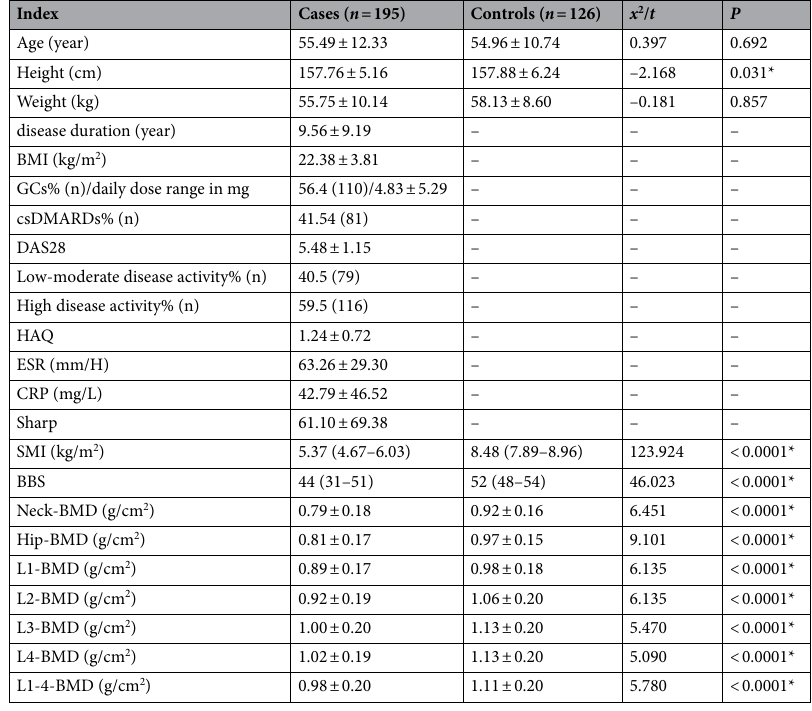
Table 1. Comparison of clinical features between female RA and controls. Mean and standard deviation for the continuous variables and number of participants (n) and percentages (%) for the categorical variables. * P value <